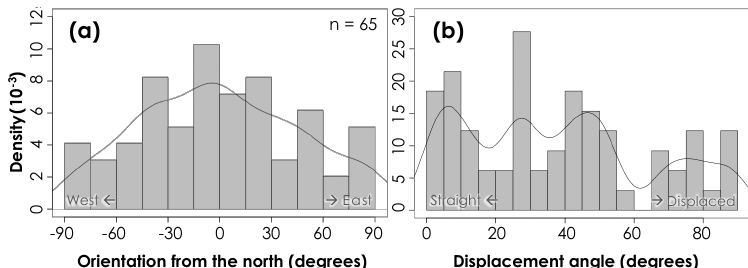
Figure 7. Horizontal angles of the direction of hummocks. (a) Orientation from the north. West is − 90 ◦ and east is 90 ◦ . (b) Displacement angle, i.e., the relative orientation of the major axis of hummock polygons to the main flow direction of the debris avalanche, given in 0–90 ◦ . The smaller displacement angle (straight to the flow direction) indicates the extensional regime of the debris avalanche, while the larger displacement angle (displaced against the flow) corresponds to the compressional regime.